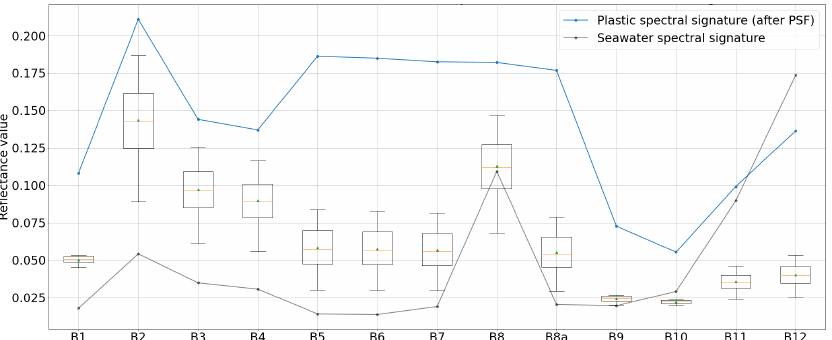
Figure 8. Results of all the possible jitters for each band by selecting the maximum reflectance values. Plastic patch of size 10m × 10m.The triangle represents the average of the corresponding dataset and the orange line, the